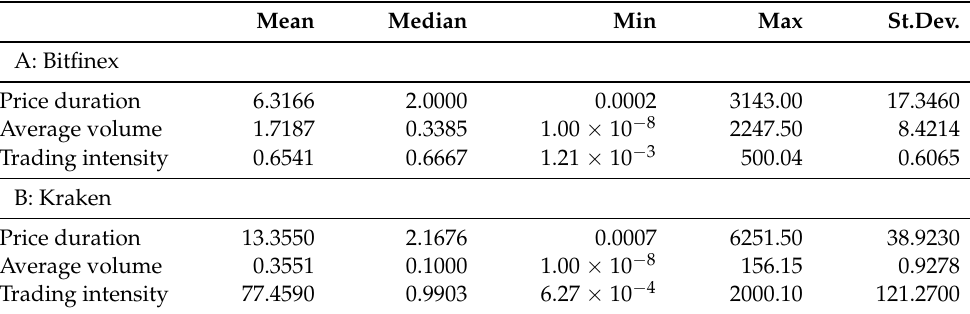
Table 1. Descriptive statistics of price durations.